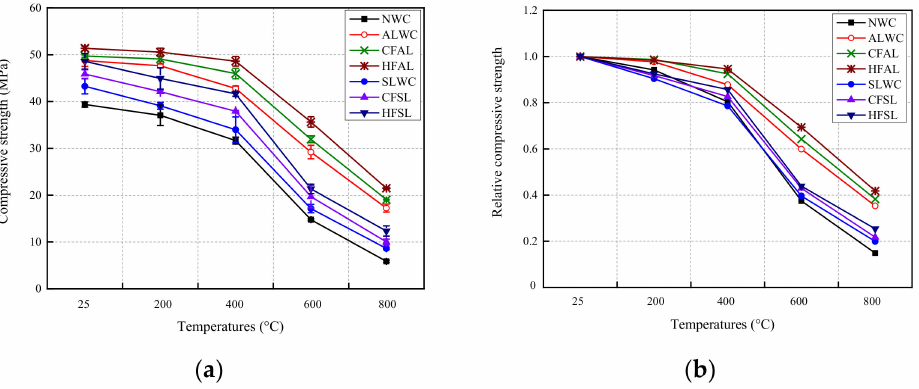
Figure 6. Temperature effect on compressive strength: ( a ) absolute compressive strength; ( b ) relative compressive